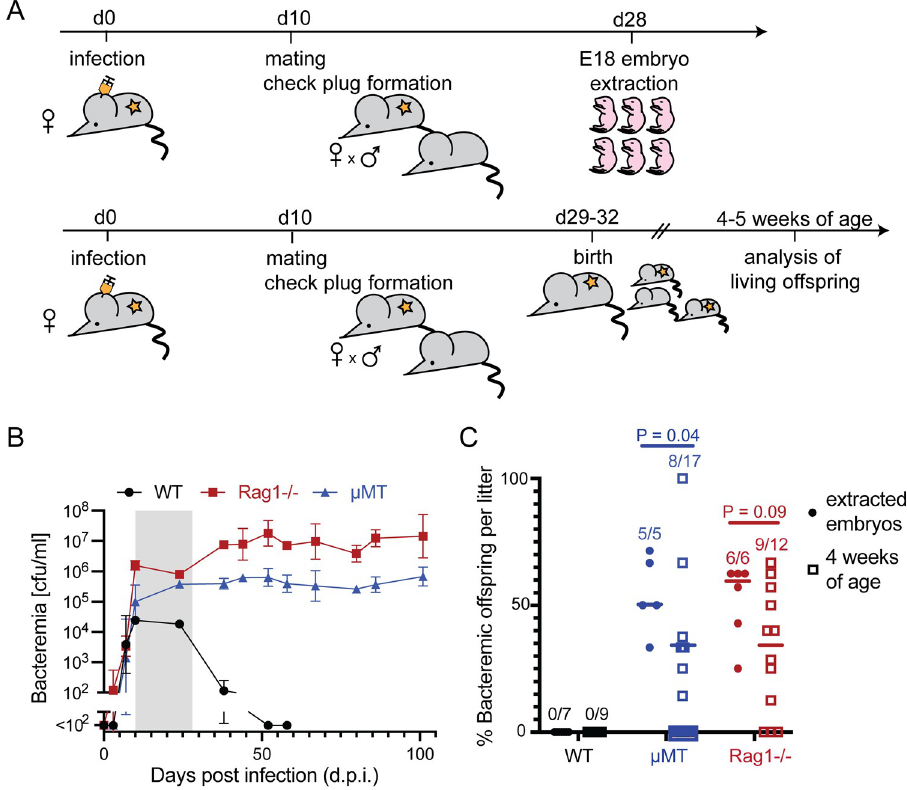
Fig 1. Efficient transplacental B. taylorii transmission in B cell-deficient but not wildtype mice. (A) Schematic overview of the experimental setup for the analysis of extracted embryos (top) and living offspring (bottom). Female WT, Rag1-/- and μ MT mice were infected with 10 7 cfu of B. taylorii i.d. and were mated 10 days later. Embryos were extracted on day 18 of gestation and offspring were evaluated at 5 weeks of age. (B) Bacteremia of WT, Rag1-/- and μ MT mice after inoculation with 10 7 cfu B. taylorii i.d.. Symbols represent the mean ± SD of three mice per group. One representative of three experiments is shown. The time window for pregnancy of WT mice (upon mating on day 10 post infection) is indicated in grey. (C) The percentage of WT, Rag1-/- and μ MT offspring harbouring B. taylorii was determined at embryonic day 18 (“extracted embryos”) and at four to five weeks after birth (“4–5 weeks of age”). Numbers above symbols in (C) indicate the percentage of litters containing at least one infected embryo or litter mate, respectively/number of litters assessed. Each symbol represents one litter, horizontal lines indicate the mean. Unpaired two-tailed Student’s t-tests were performed for statistical analysis. Related data are reported in S1 Fig.